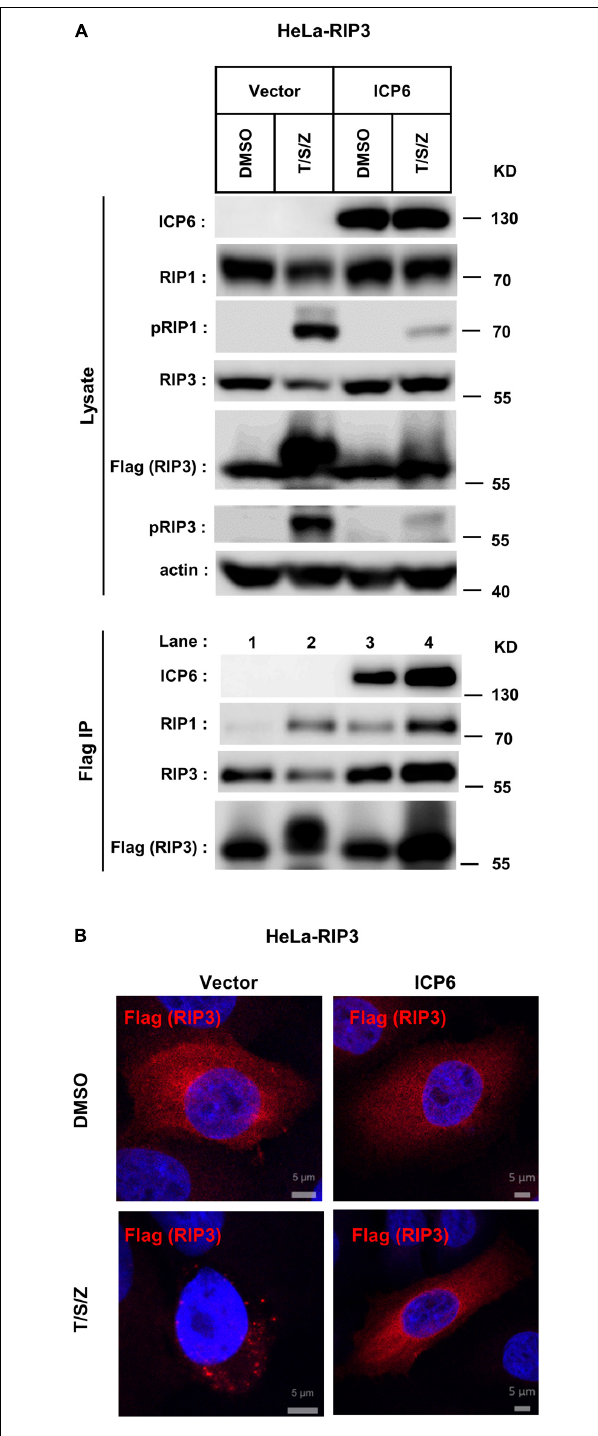
FIGURE 3 | ICP6 promotes necrosome initiation but block necrosome maturation. (A) HeLa-RIP3 cells (HeLa with exogenous Flag-tagged RIP3 expression) infected with empty virus (Vector) or lentiviral virus encoding ICP6 were cultured in the presence of T/S/Z for 6 h. Whole-cell lysates were subjected to immunoprecipitation with anti-Flag M2 beads. The total cell lysates and immunoprecipitates were immunoblotted with the